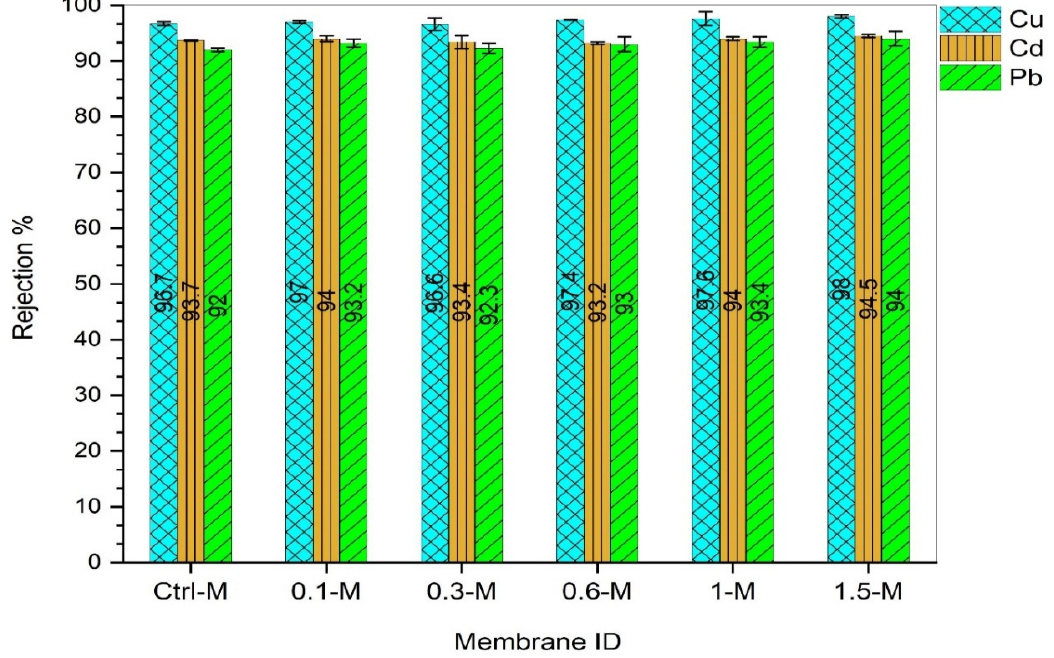
Figure 11. Rejection rate of NF nanocomposite membranes against copper, cadmium and lead feed solutions (50 ppm, 3 bars, pH = 7, 1LMH and 25 °C).